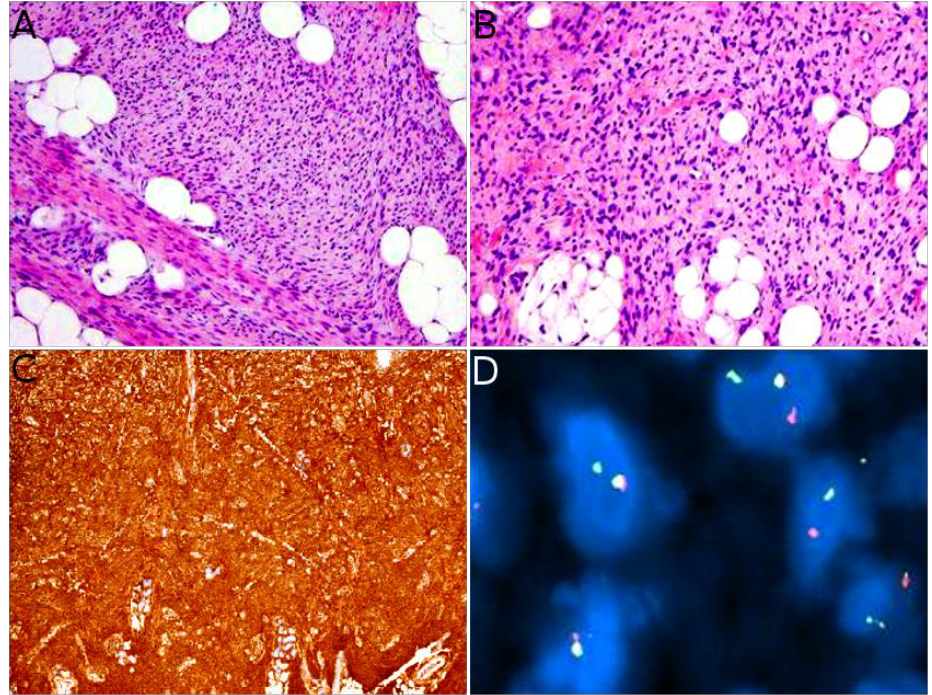
Figure 4. NTRK -rearranged spindle cell neoplasm: ( A ) Infiltrative growth pattern within the subcutaneous fat, with spindle cells haphazardly arranged or in fascicles (×100); ( B ) mild atypia and hyperchromasia (×100); ( C ) diffuse positivity for pan-TRK (×25); ( D ) fusion signals involving NTRK on FISH.